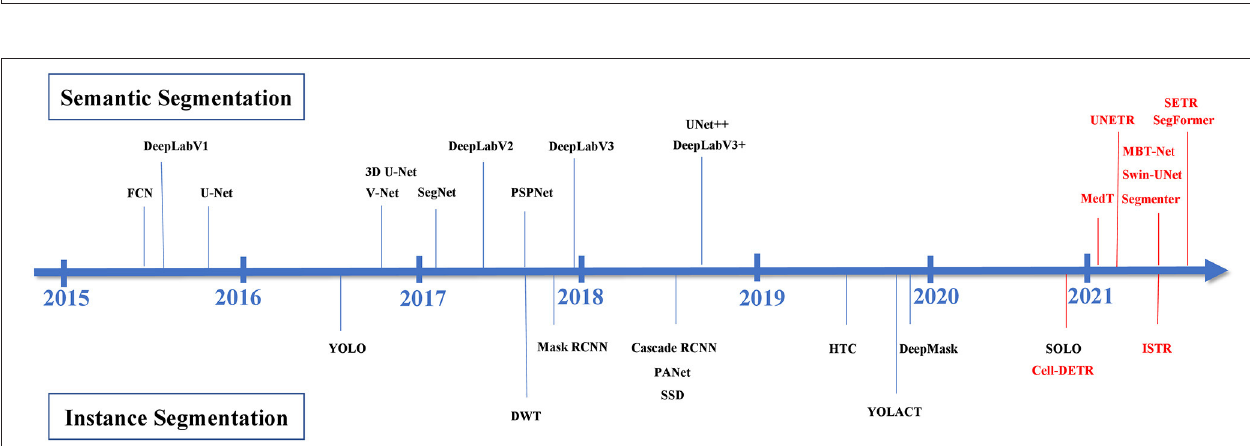
FIGURE 3 | The development of automatic image segmentation. The black represents CNN-based methods and the red shows Transformer-based methods.